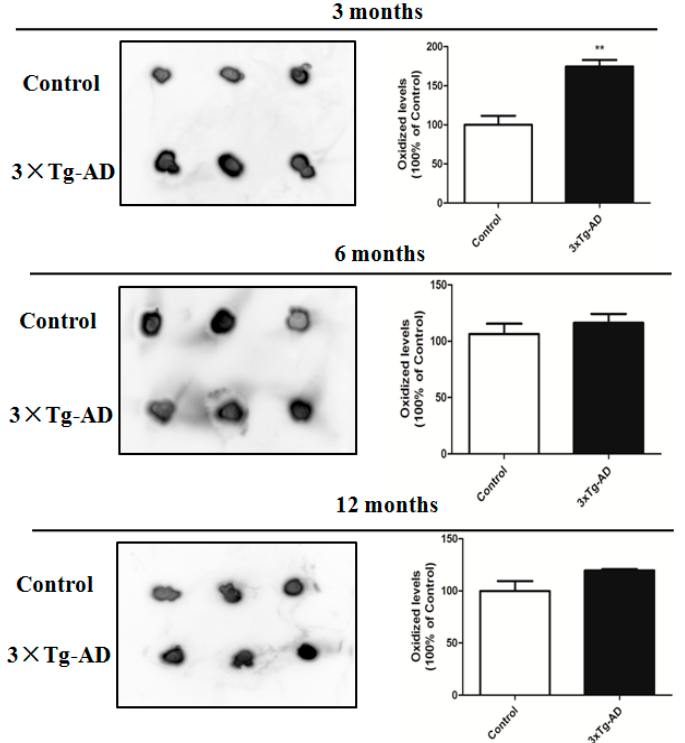
Figure 1. Total protein carbonylated levels in the serum of 3×Tg-AD mice compared with their controls at three, six, and 12 months of age. Slot-blot detection of protein carbonyls ( left ). The histogram shows the alteration of protein carbonylated levels ( right ). The level of protein carbonyls is normalized with the mean of the controls ( n = 3). ** p < 0.05, statistically significant difference compared with the control.